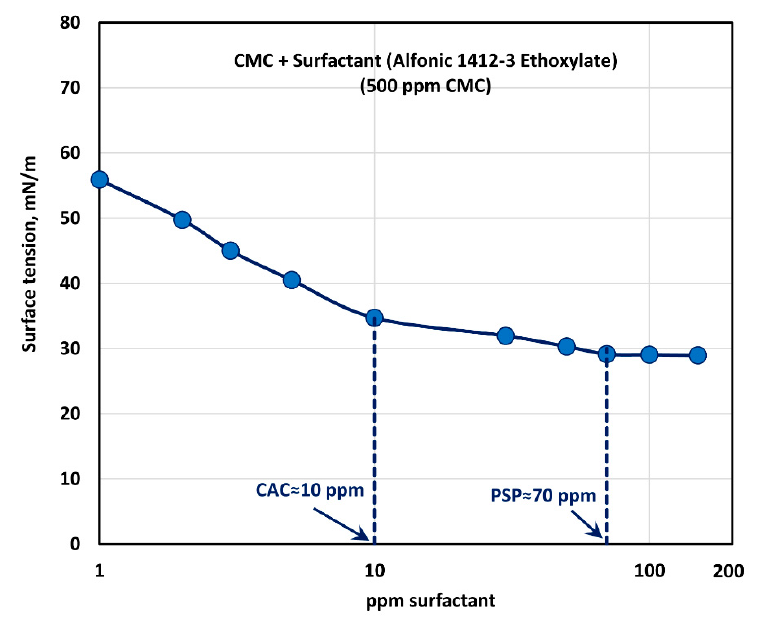
Figure 13. Variation of surface tension of surfactant-polymer solutions with the increase in surfactant (Alfonic 1412-3 Ethoxylate) concentration, at a fixed polymer (CMC) concentration of 500 ppm.